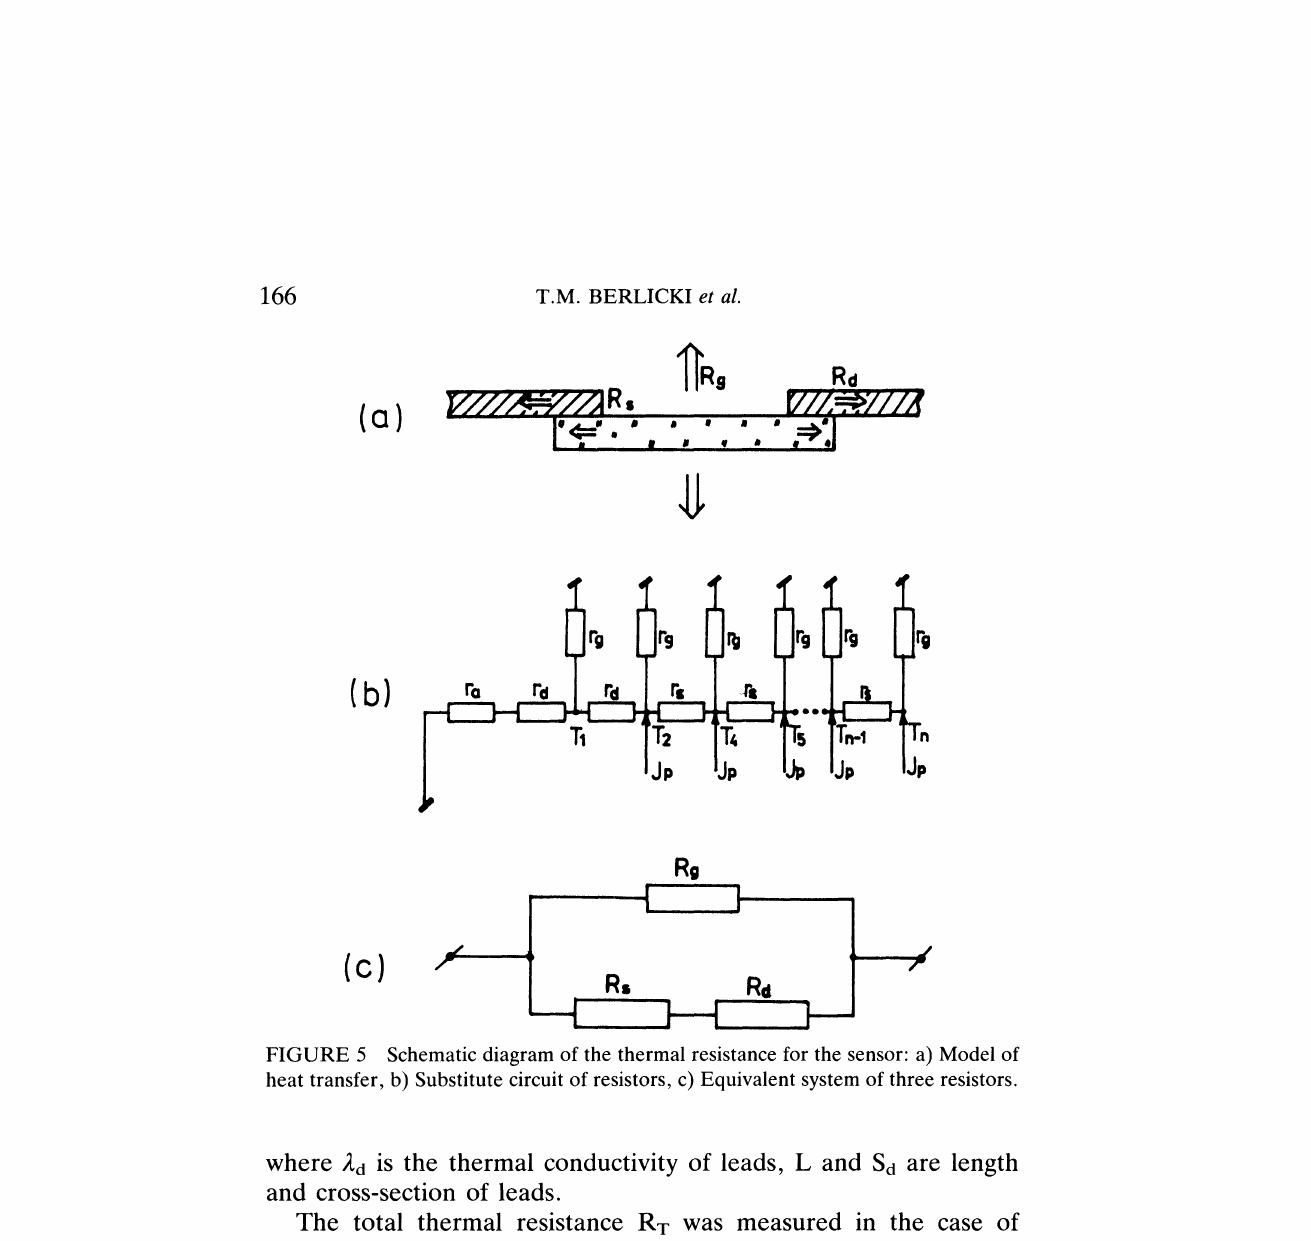
FIGURE 5 Schematic diagram of the thermal resistance for the sensor: a) Model of heat transfer, b) Substitute circuit of resistors, c) Equivalent system of three